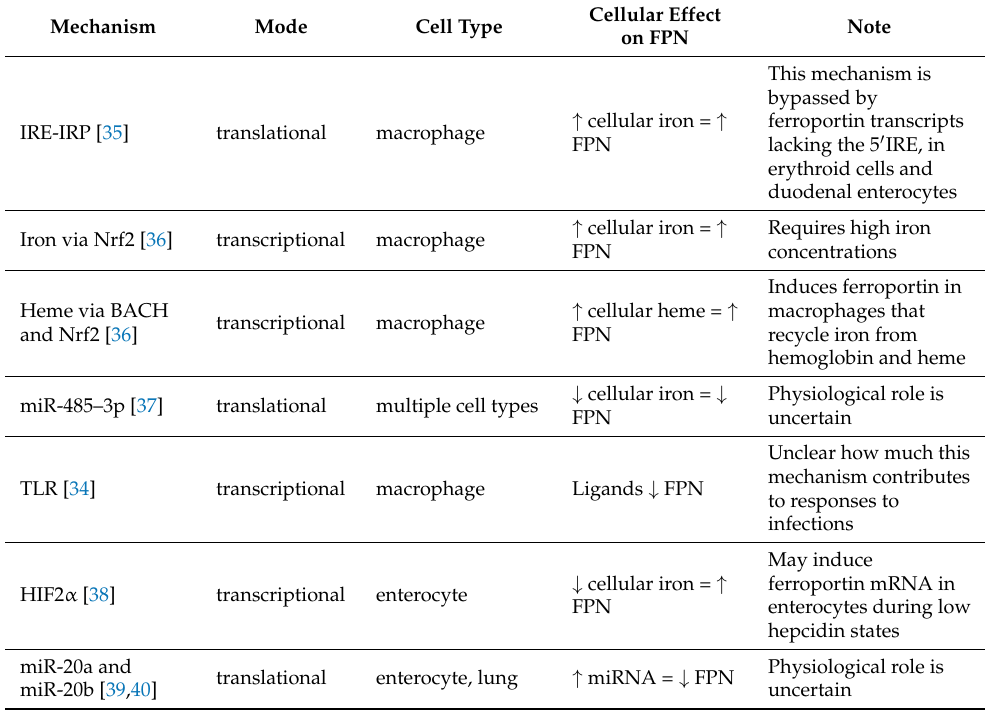
Table 1. Hepcidin-independent mechanisms that regulate